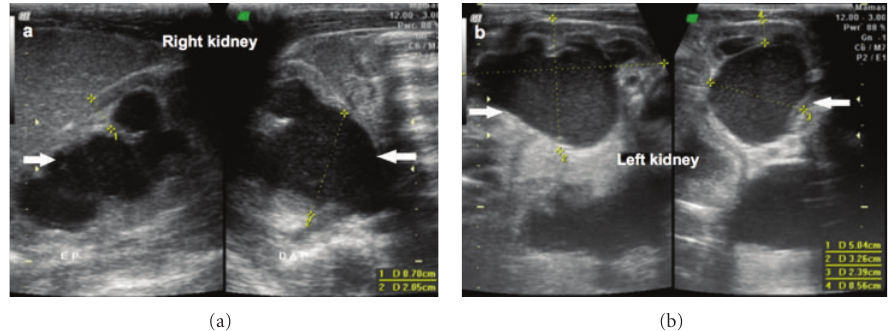
Figure 3: Ultrasound scan in sagittal plane at the level of the kidneys shows bilateral hydronephrosis of dense content (white arrows): (a) in the right kidney; (b) left